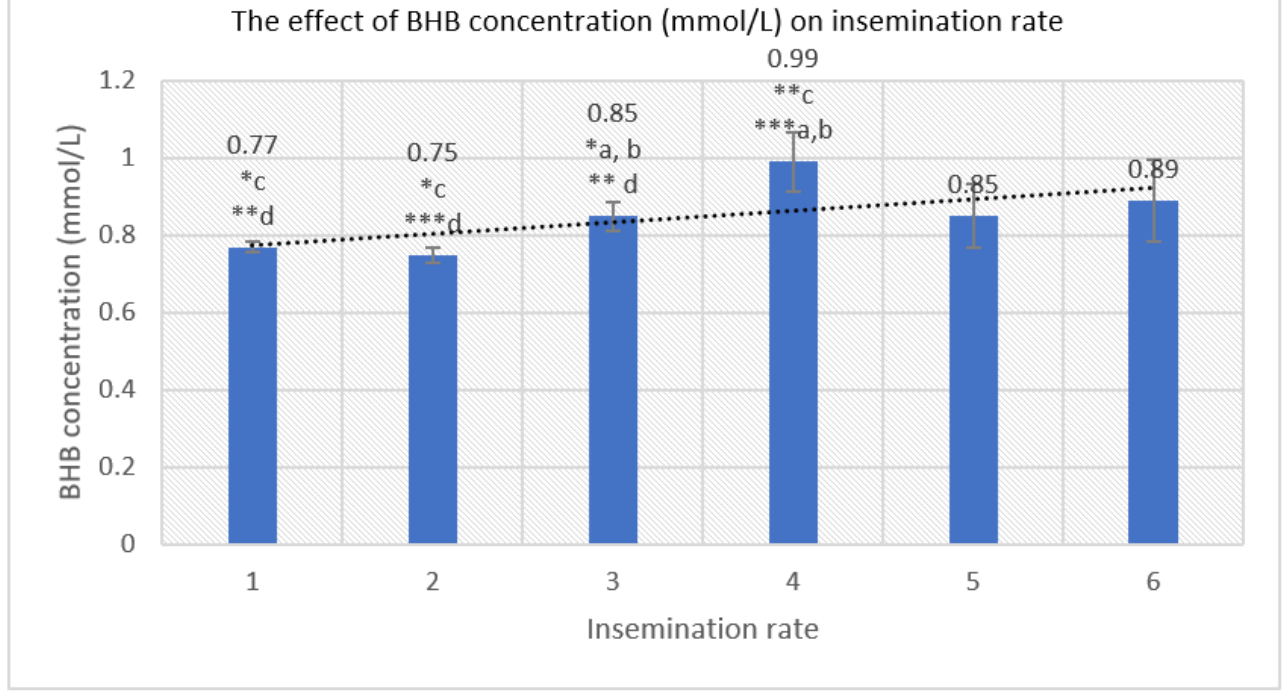
Figure 2. The relationship between mean BHB concentration (mmol/L) on second week of lactation and insemination rate. a – f — marking with different letters indicates the mean differences between the investigated indicators. *** p < 0.001; ** p < 0.01; * p < 0.05. the investigated indicators. *** p < 0.001; ** p < 0.01; * p < Higher BHB concentration in WK 2 was related to delayed first insemination day.